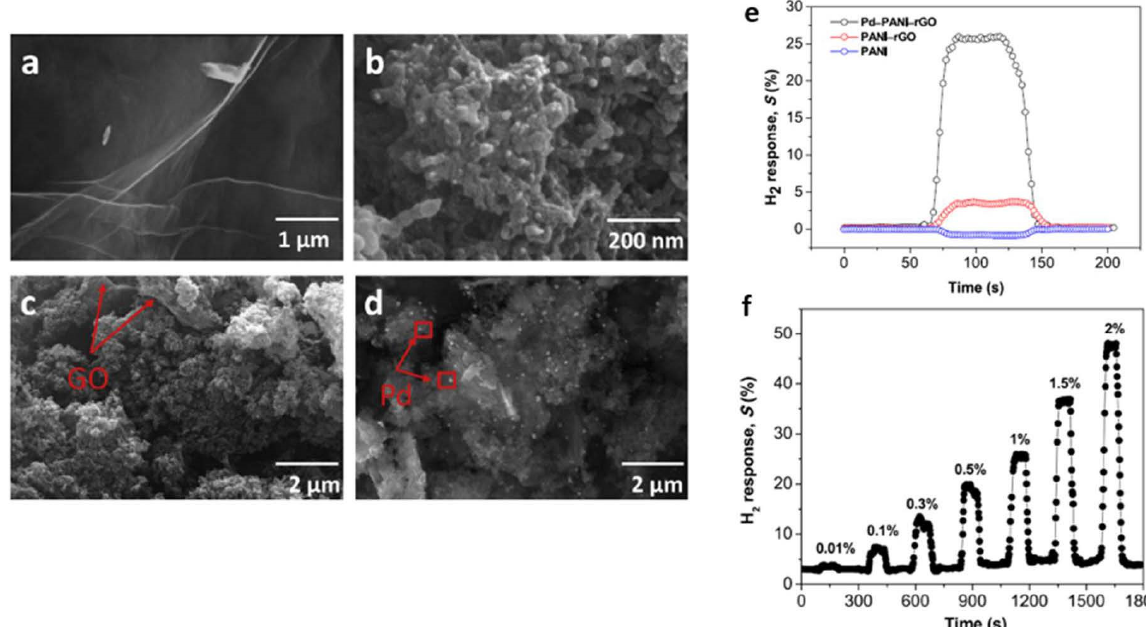
Figure 38. Scanning electron microscope (SEM) images of ( a ) rGO, ( b ) PANI (polyaniline), ( c ) PANI-rGO (reduced graphene oxide) and ( d ) Pd-PANI-rGO. ( e ) Gas sensing response of the PANI, PANI-rGO and Pd-PANI-rGO thin films exposed to 1% hydrogen concentration at room temperature. ( f ) Gas sensing response of the Pd-PANI-rGO based sensor to different concentrations of hydrogen at room temperature [176]. Copyright (2016), with permission from Elsevier.